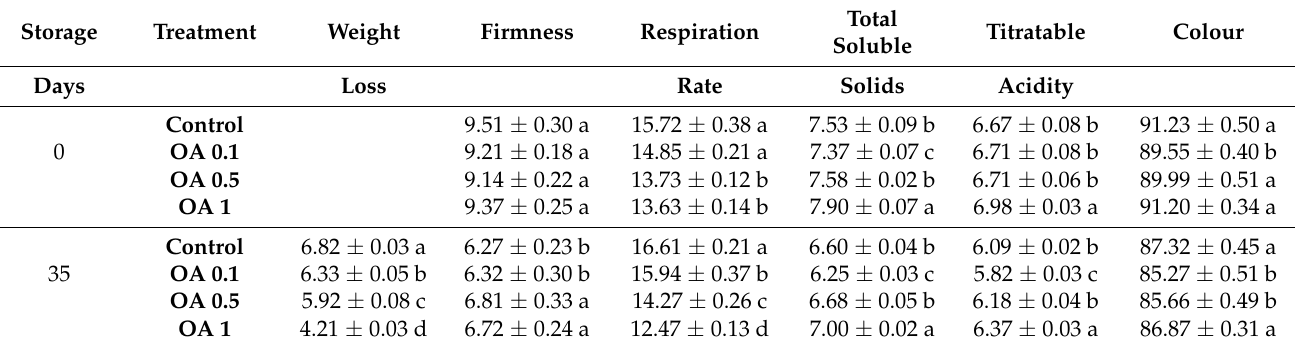
Table 1. The effects of oxalic acid (OA) at 0.1, 0.5, and 1 mM preharvest treatments on weight loss (%), firmness (N mm − 1 ), respiration rate (mg kg − 1 h − 1 ), total soluble solids ( ◦ Brix), total acidity (g 100 g − 1 ), and colour (hue angle) over35 days of storage at 10 ◦ C in the 2019 experiment. Data are the mean ± SE of four replicates. Different lowercase letters in the same column indicate significant differences ( p < 0.05) among the treatments for each sampling